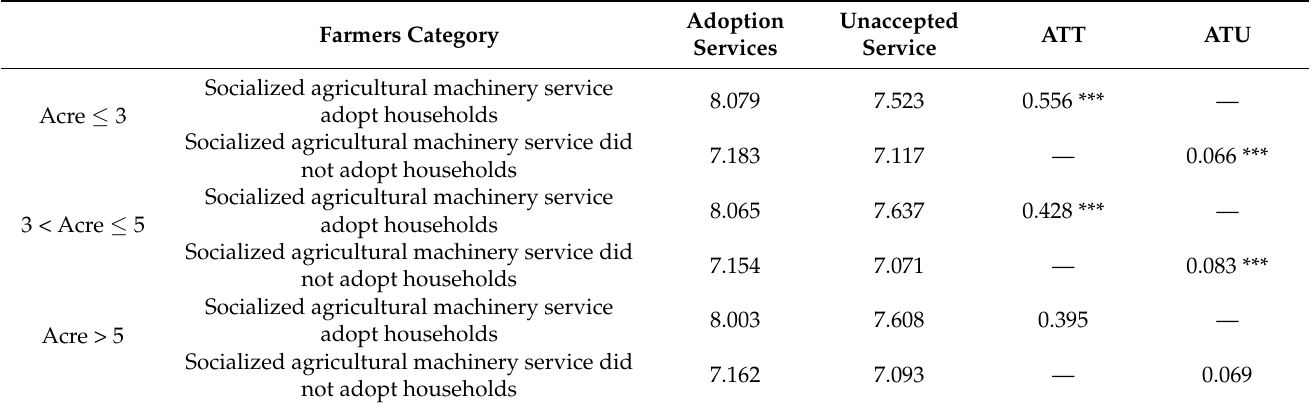
Table 6. The impact of socialized agricultural machinery service on land productivity based on scale heterogeneity.